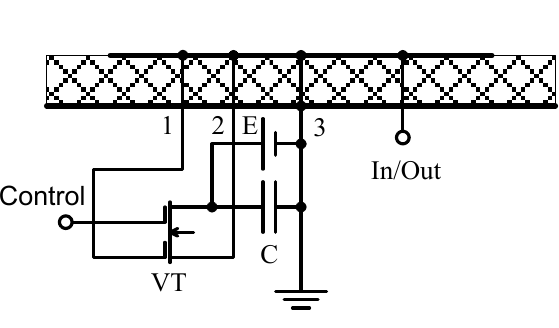
Fig. 3. The microwave amplifier schematic